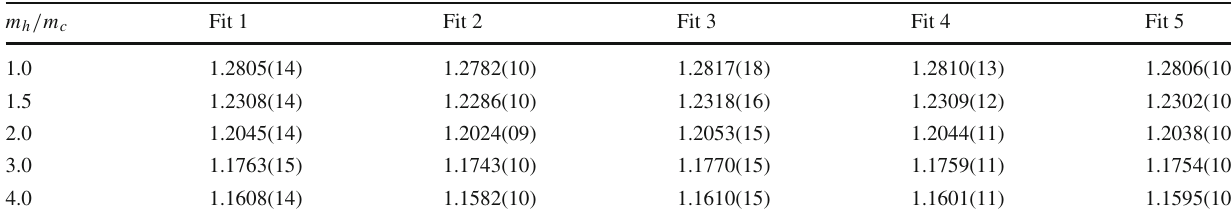
Table 3 The continumm extrapolated values of R 4 at different heavy quark masses, m h from different fits which include terms proportional to log ( am h 0 ) , see